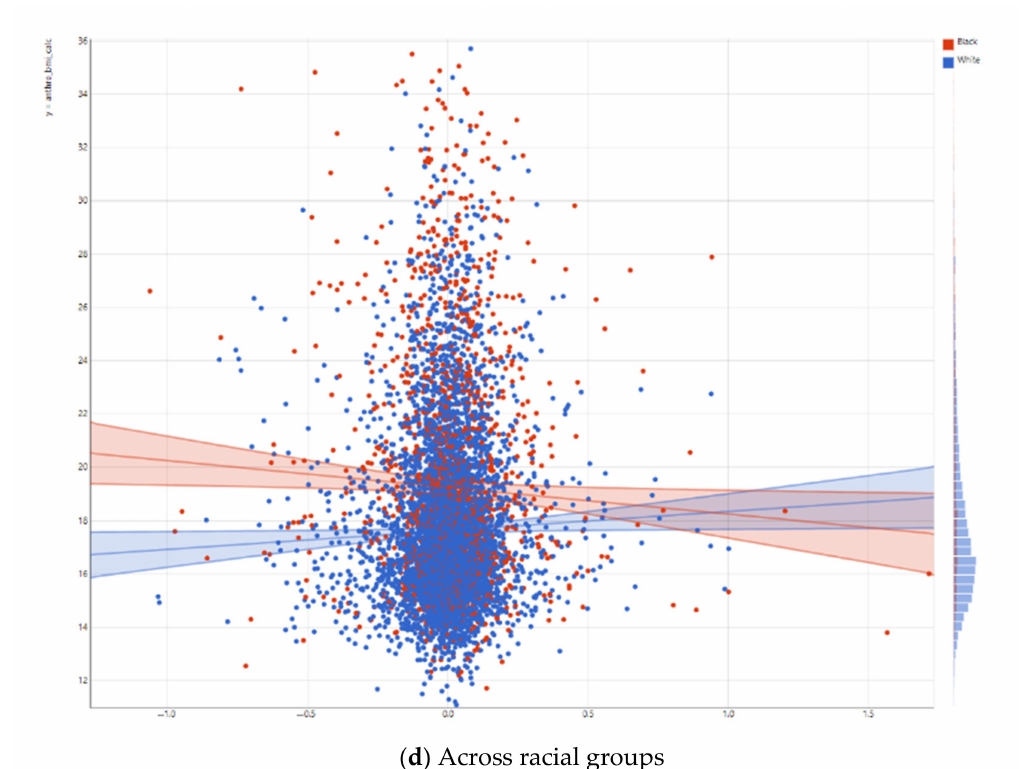
Figure 1. Association between right putamen functional connectivity to the salience network and children’s body mass index